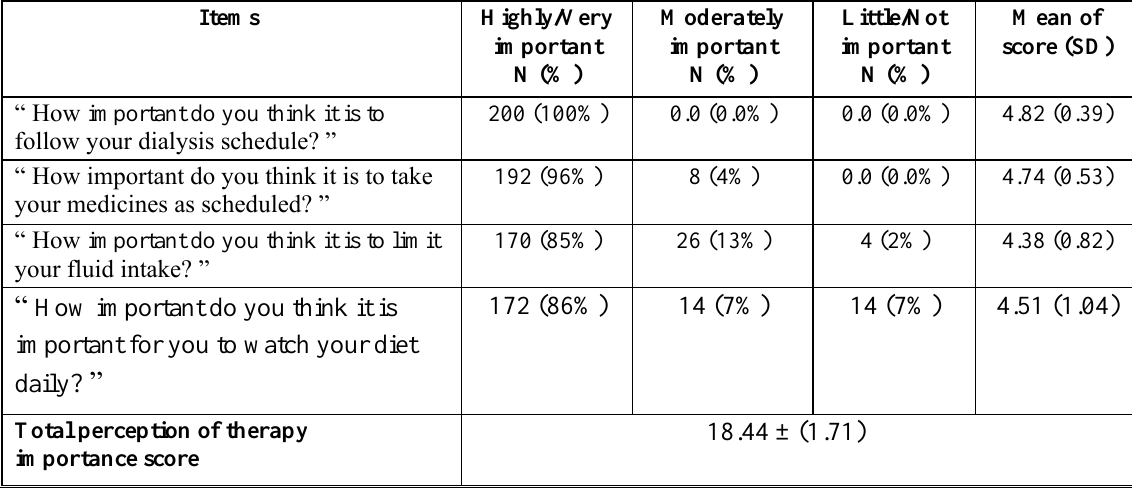
Table 4.The importance perceptions of following the recommended dialysis, medicines, fluid and